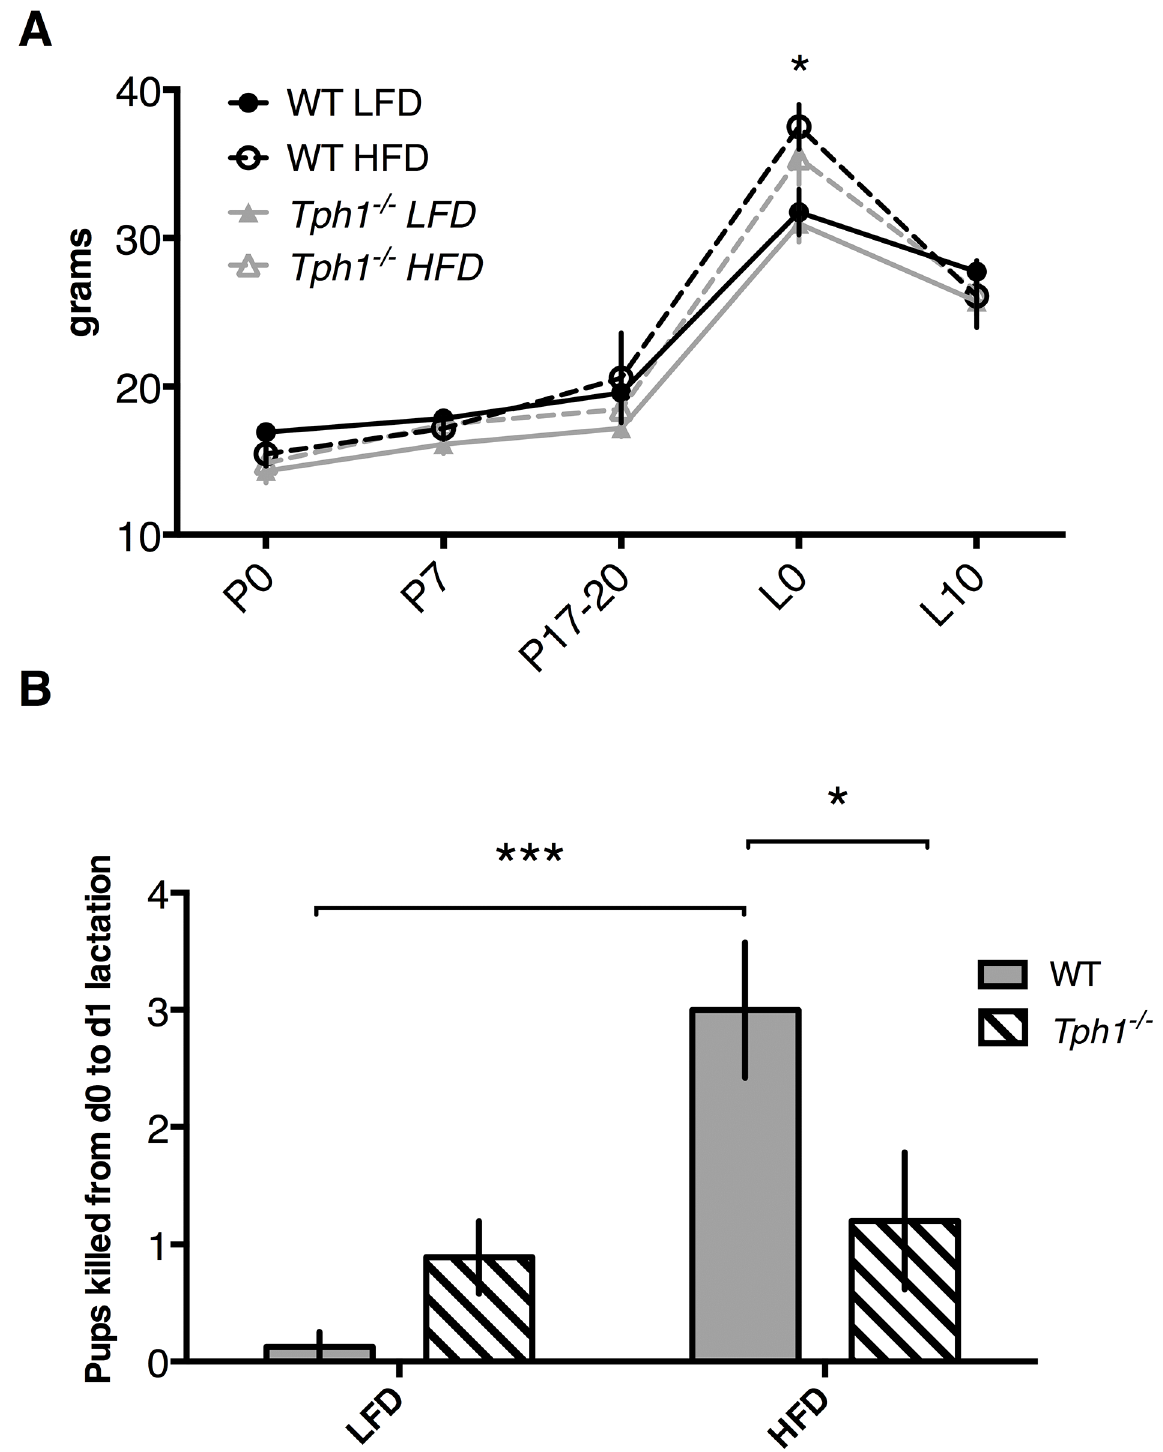
Fig 1. All dams fed a high fat diet weighed more than those fed a low fat diet, but only wild type high fat diet fed dams killed more pups at the onset of lactation. Wild type or Tph1 deficient dams were either fed a high fat or low fat diet throughout pregnancy and lactation. Shown in ( A ) are the effects on dam weight and in ( B ) on pup mortality. Values are means ± SEMs. Stars indicate statistical significance between groups ( * = 0.05 < P < 0.01, ** = 0.01 < P < 0.001, *** = 0.001 < P < 0.0001). WT, wild type; Tph1 -/- , Tph1 deficient; LFD, low fat diet; HFD, high fat diet; P0, day 0 of pregnancy; P7, day 7 of pregnancy; P17-20, day 17 to 20 of pregnancy; L0, day 0 of lactation; L10, day 10 of lactation.